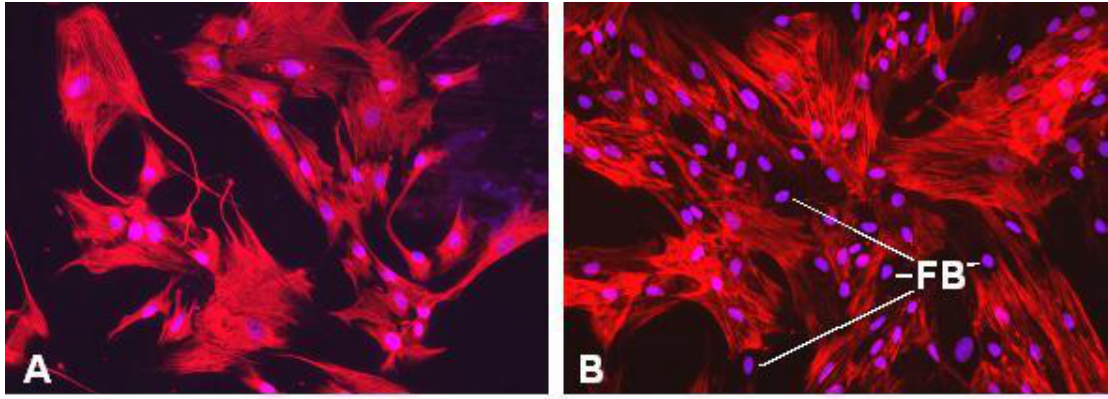
Figure 2. Immunofluorescence microscopy of cultured PSC, which have been isolated from pancreatic ductal adenocarcinoma. (a) vimentin immunofluorescence (red); (b) alpha-smooth muscle actin immunofluorescence (red). Cell nuclei are stained blue (Hoechst 33258). FB, alpha-smooth muscle actin negative